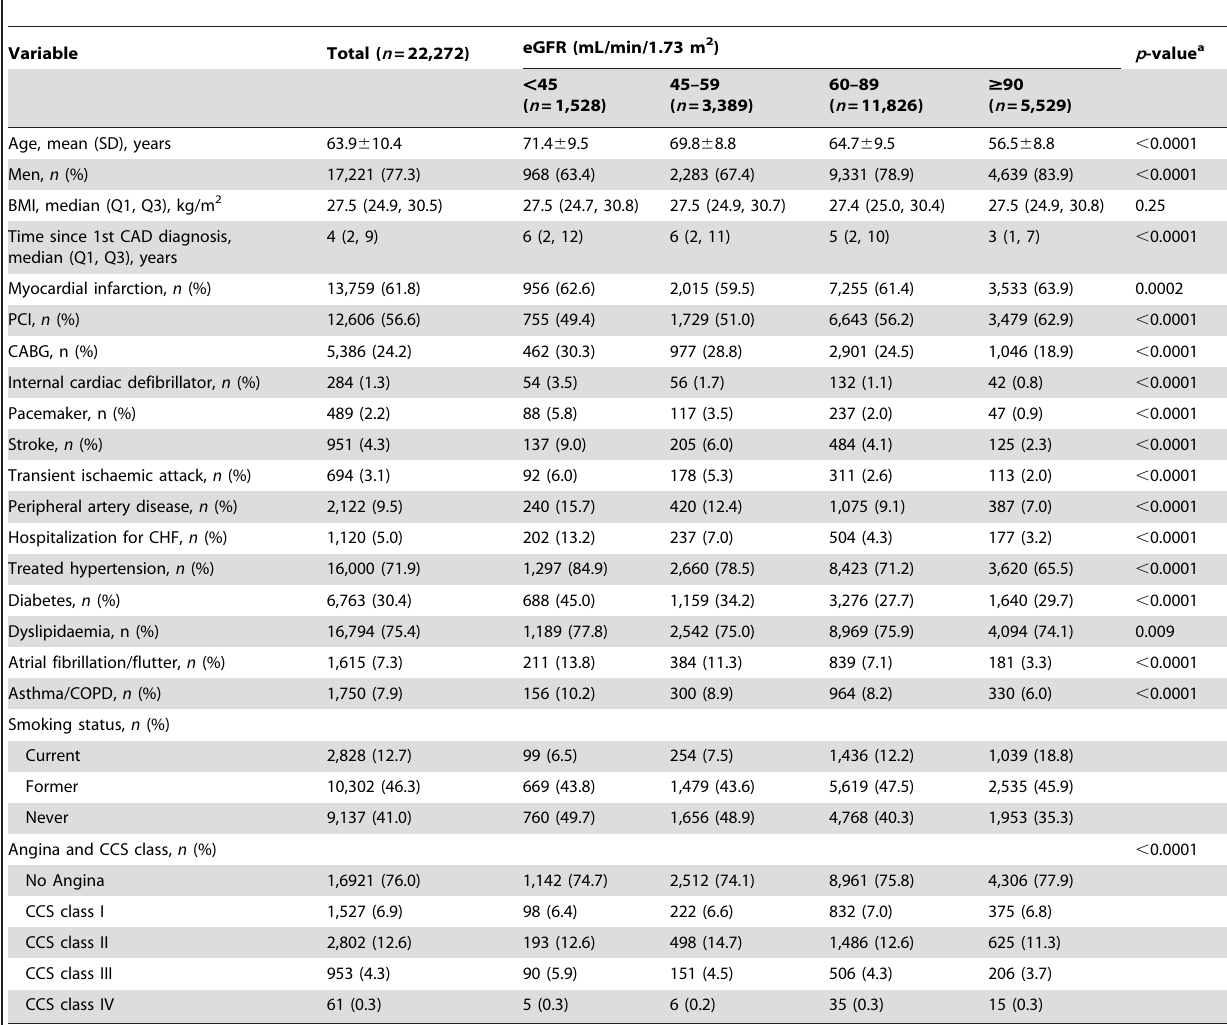
Table 1. Demographic data: characteristics of the study population classified according to eGFR group calculated using the CKD-